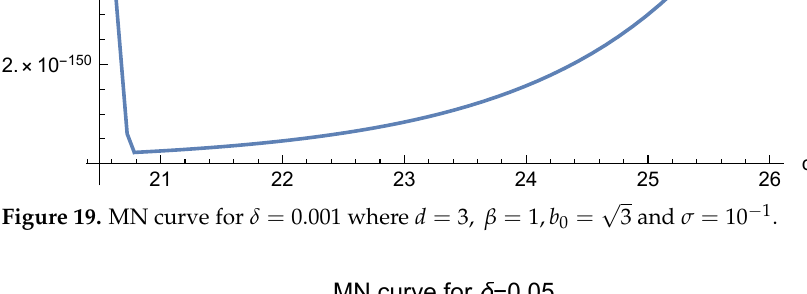
Figure 19. MN curve for δ = 0.001 where d = 3, β = 1, b 0 =